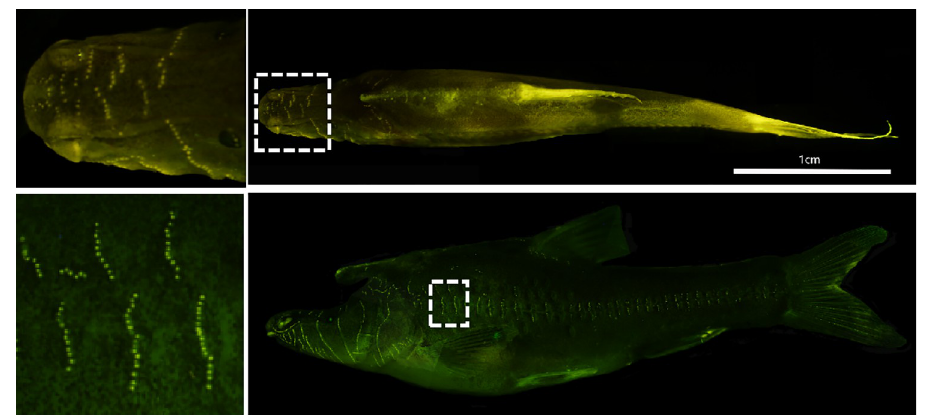
Fig 2. Superficial neuromasts distribution of S . rhinocerous . The yellow dots are the superficial neuromasts obtained by DASPEI stain. The upper two photographs show a dorsal view and the lower two show a side view of the S . rhinocerous